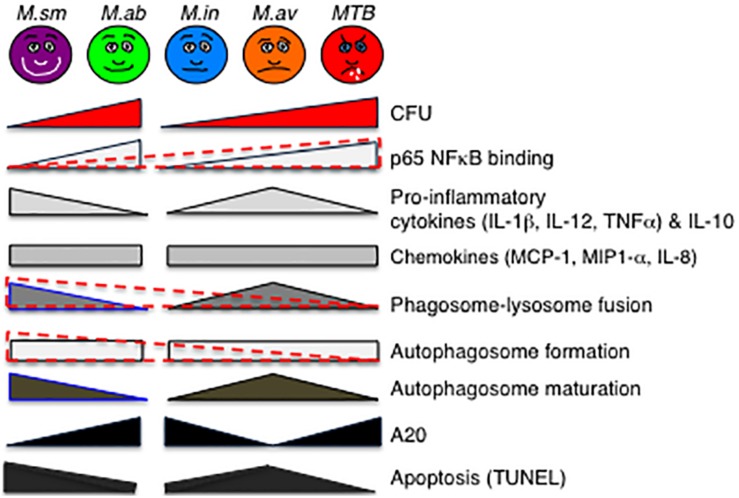
Qualitative diagram of the relationship between CFU and effector functions of macrophages infected with MTB and NTM. See the section “Discussion” in text. For p65-NF-κB activation, phagosome–lysosome fusion, and autophagosome formation, the data are displayed separately for the RGM (M. smegmatis and M. abscessus) and SGM (M. intracellulare, M. avium) plus MTB (different geometrical shapes with various shades of gray) but also combined (overlaying red-dashed triangles). While it is more difficult to generalize the relative induction of apoptosis with the NTM species, MTB induced the least amount of apoptosis and apoptotic phenotypic markers in the infected macrophages. CFU, colony forming units; NF-κB, nuclear factor kappa B; M. sm, M. smegmatis; M. ab, M. abscessus; M. in, M. intracellulare; M. av, M. avium; MTB, M. tuberculosis.